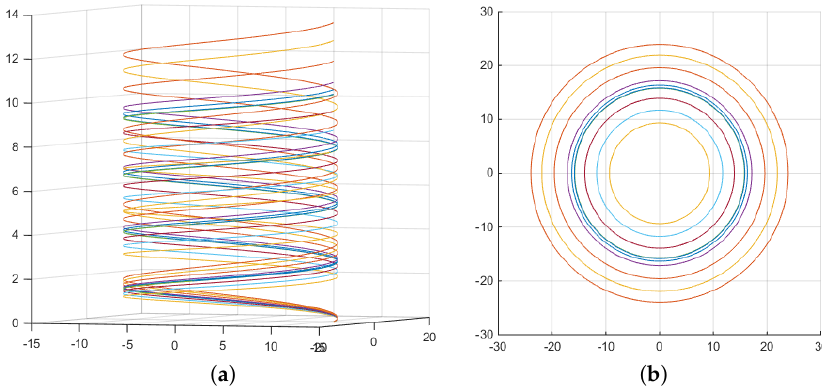
Figure 1. Simulated curves. ( a ) Ten spirals with different shapes and common length. ( b ) Ten circumferences with common shape and different lengths.